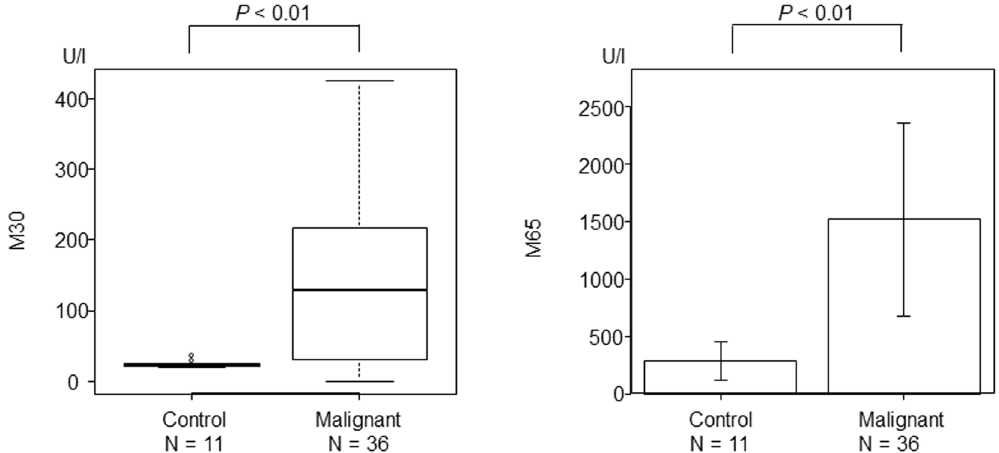
Figure 2. The comparison of cell death biomarkers between the control and Malignant groups. Significantly higher levels of both M30 and M65 were observed in the Malignant group than in the control group.